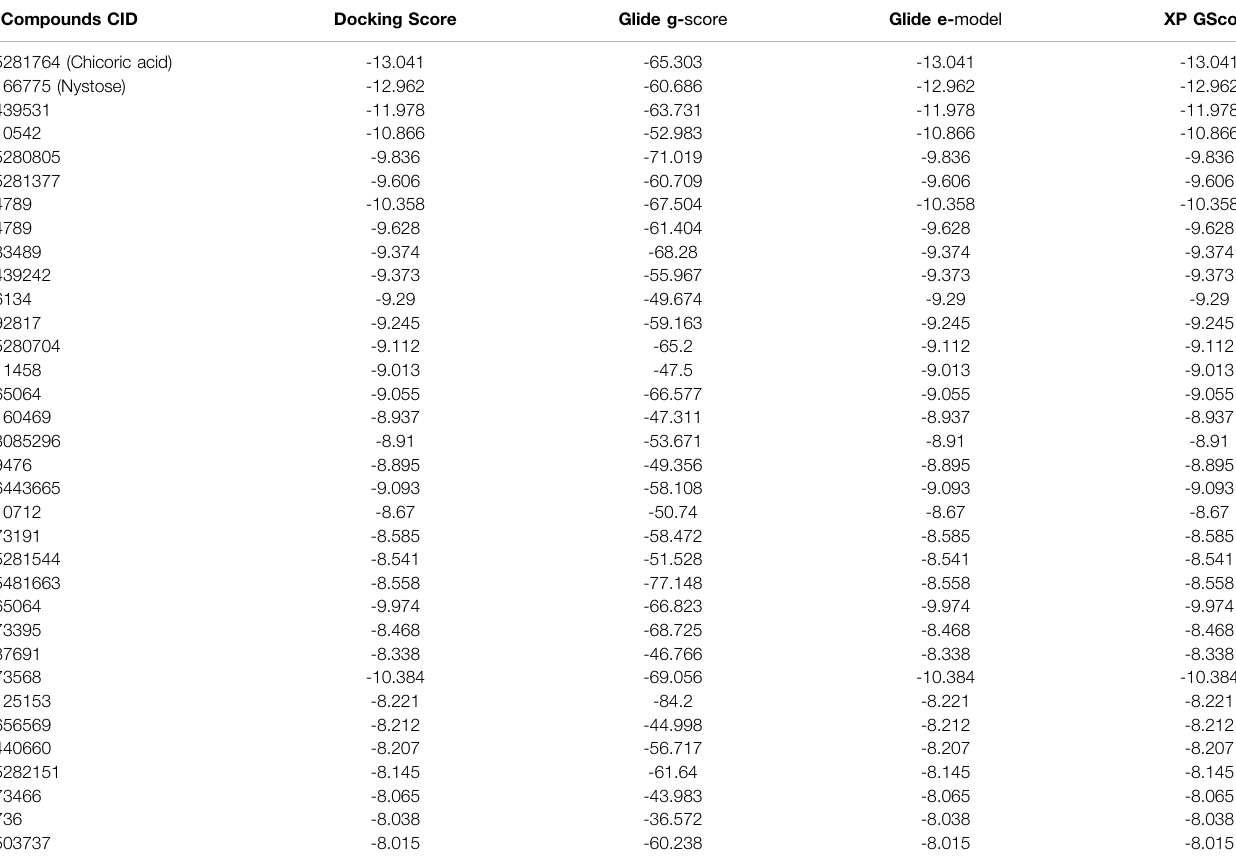
TABLE1| Insilicoscreening/dockingresultsofthedockedligandsthatwereselectedowingtotheirmostnegativedockingscores,withSRAdomain ofE3ubiquitin-protein ligase UHRF1(PDB: 3BI7). a Compounds